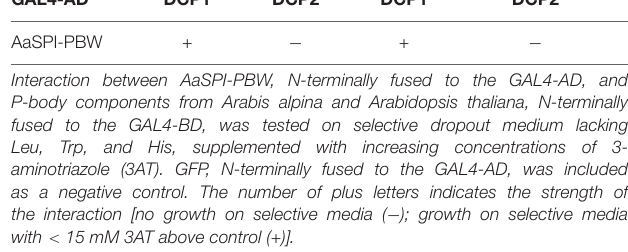
Frontiers in Plant Science |